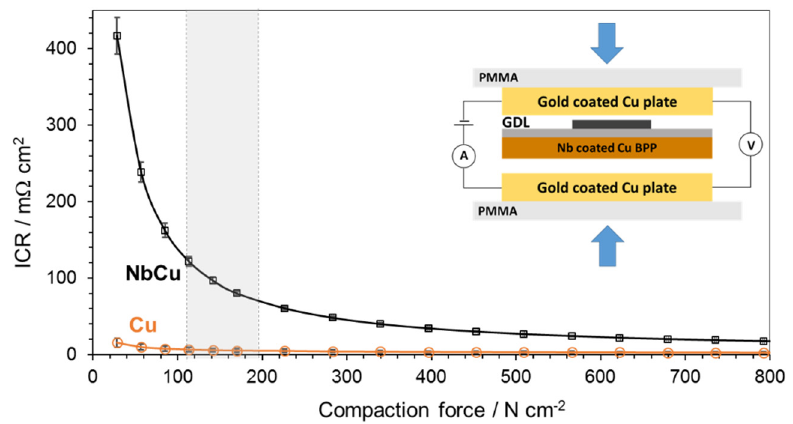
Figure 2. Interfacial contact resistance of Cu substrate and Nb-coated Cu pole plate at different compaction forces. Shaded area on the X-axis corresponds to the pressure range used for assembling commercial PEM electrolyzer stacks. Inset shows the experimental setup for ICR measurements.